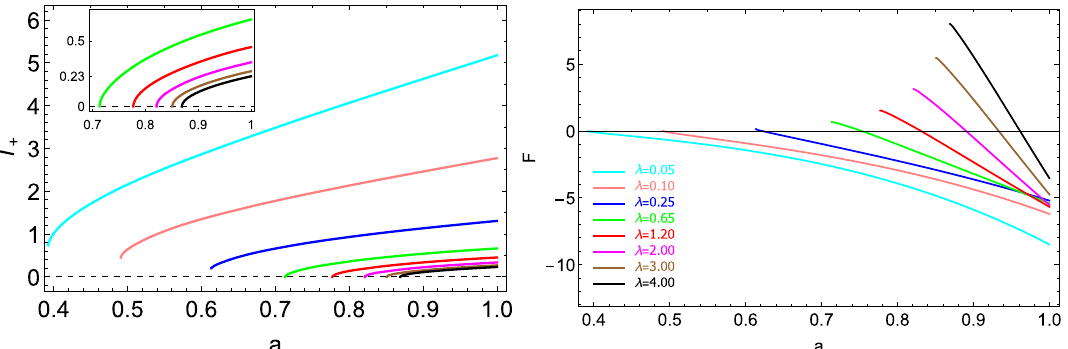
Fig. 5 The Hawking temperature (left) and free energy (right) of thermalon configuration as function of a for various value of λ with k = 1, L = 1, γ a = − 2 . 296, γ b = 2 . 048 and γ c = 0 .